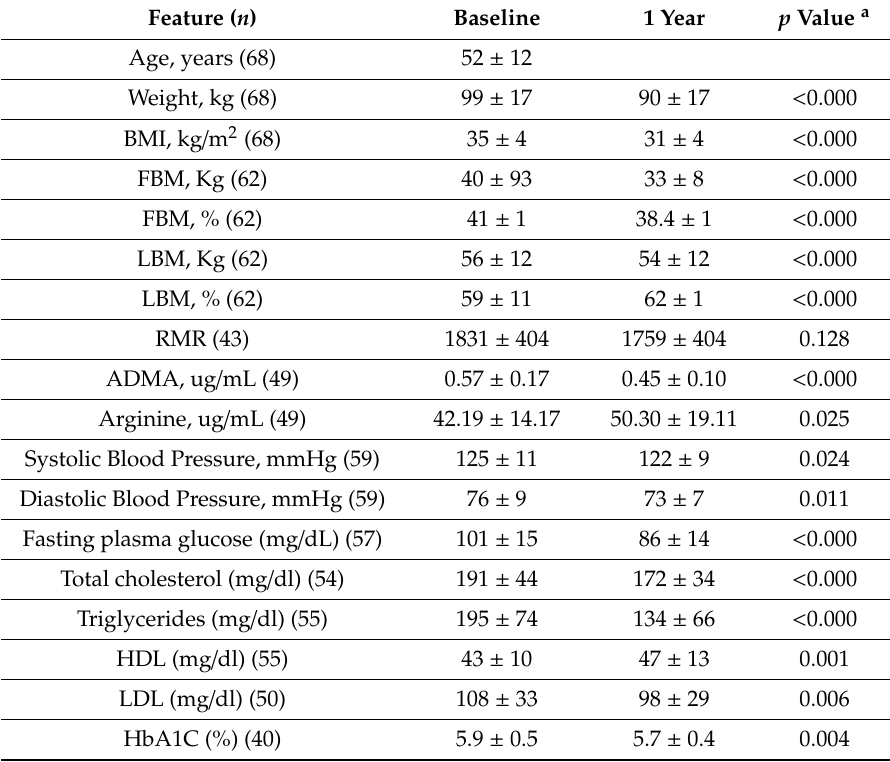
Table 1. Clinical, anthropometric and biochemical features of the study’s participants at the initiation of the study and after one year.